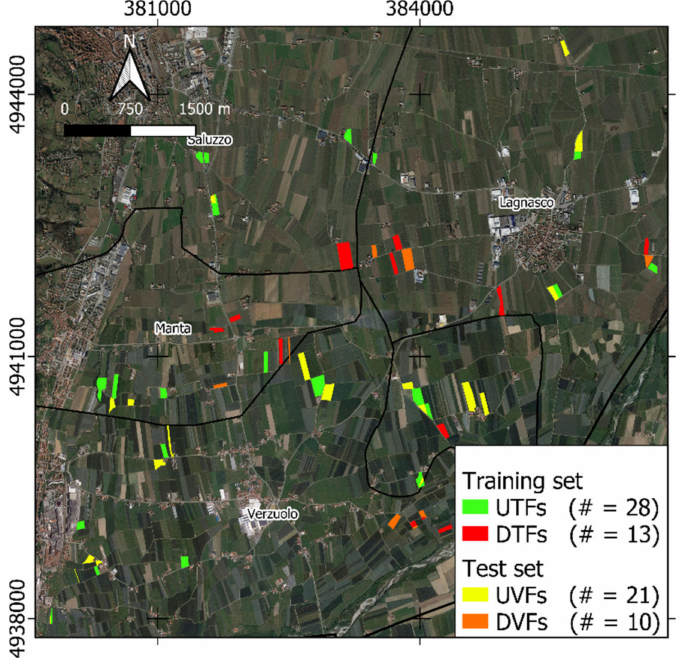
Figure 3. Parcels belonging to the training and test sets. Colors (see legend) define the state of the surveyed parcel (damaged/undamaged). Reference frame is WGS84 UTM